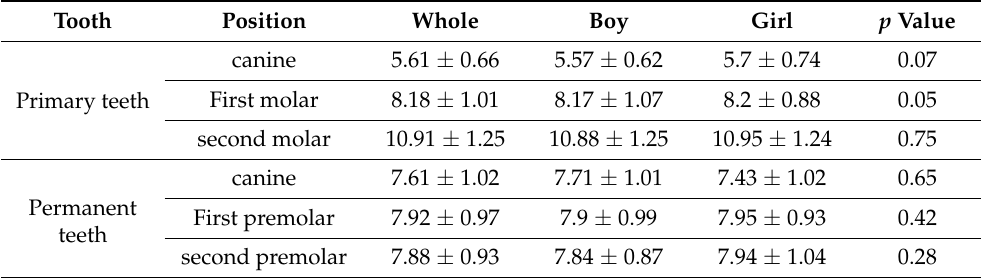
Student’s t test was performed to compare the measurements between boys and girls. Bold font indicates statistical